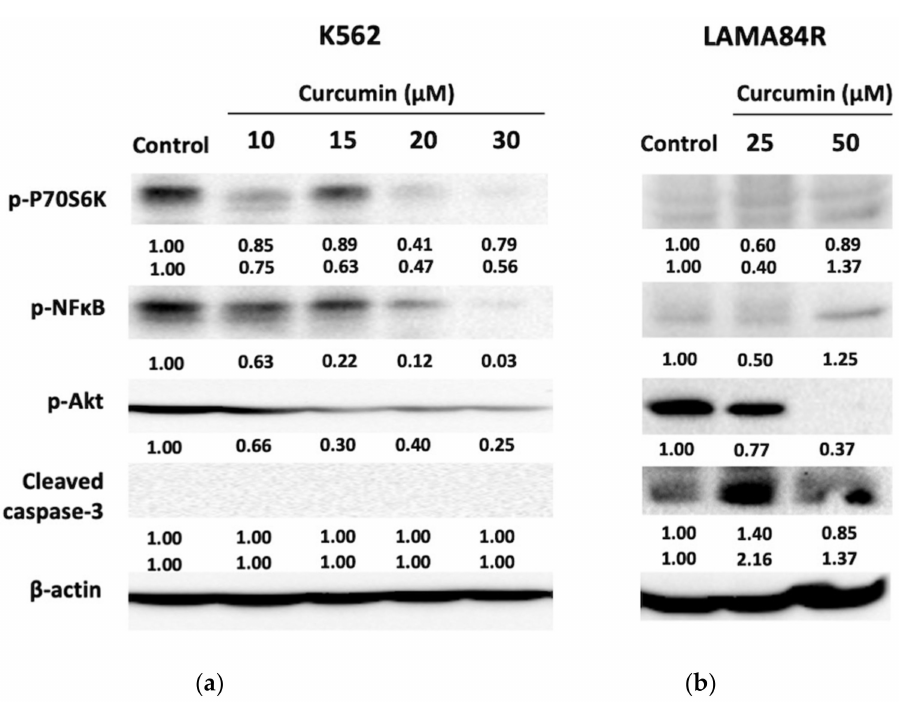
Figure 5. Analysis of protein expression/activity upon 48 h curcumin treatment of K562 ( a ) and LAMA84R ( b ) cell lines. Numbers below the bands represent a net image fold difference in the band intensity compared to a control and normalized against